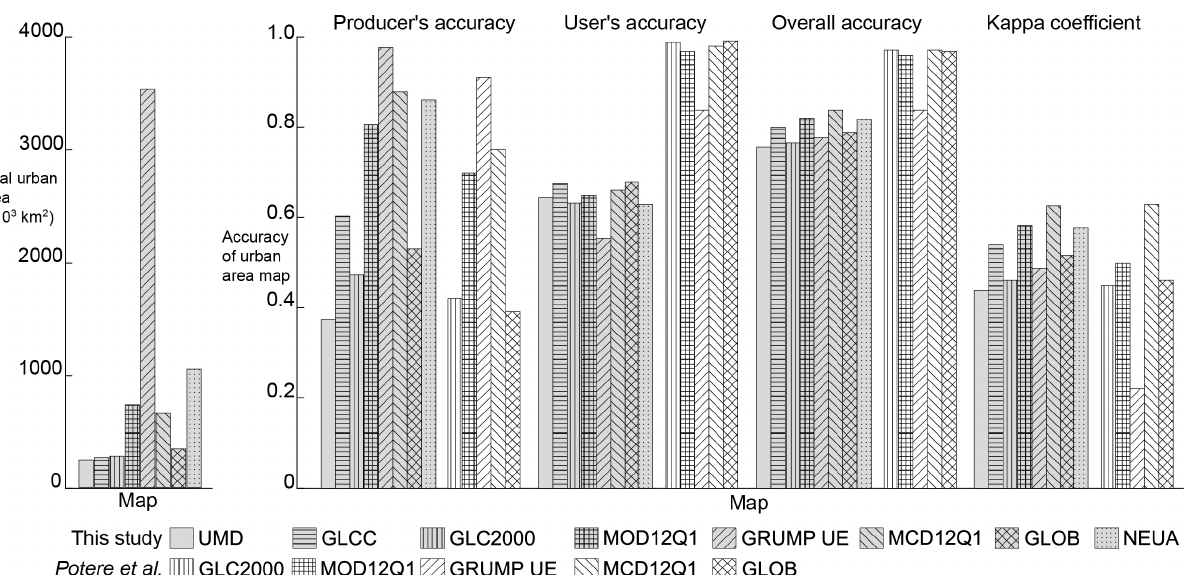
Figure 5. The total urban area and the assessed accuracies of each map in this study and in Potere et al.